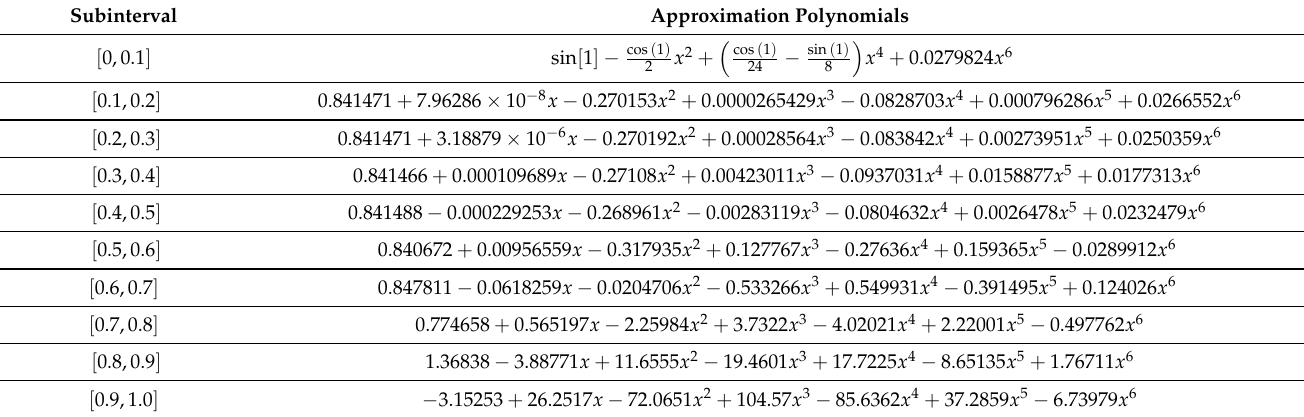
Table 7. Approximation spline for problem (32).